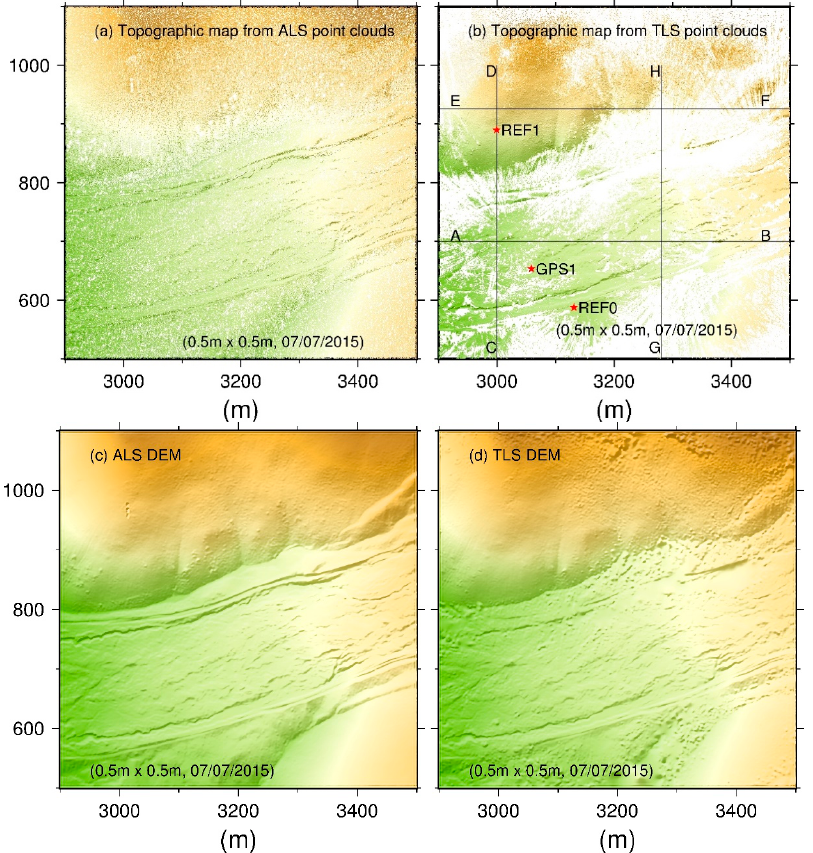
Figure 11. Comparisons of elevation measurements derived from ALS and TLS surveys on 7 July 2015. Both ALS and TLS points have been down-sampled to 0.5-m by 0.5-m grid cells. The location of the scan area is marked in Figure 3b. ( a ) Elevation measurements of the bare-earth ALS points. ( b ) Elevation measurements of the bare-earth TLS points. ( c ) A shaded DEM map derived from the ALS points illustrated in ( a ). ( d ) A shaded DEM map derived from the TLS points illustrated in ( b ). The comparisons of elevation measurements from ALS and TLS points along two profiles (AB and CD) are illustrated in Figure 12. Figure 12c illustrates the differences of the point-elevations along profile AB. The differences indicate the errors of ALS points with regard to TLS measurements and only the cells that have both ALS and TLS points are compared. The mean of the errors is 4 cm with a standard deviation ( σ ) of 34 cm. Root mean square of errors (RMSE) retains a similar value as the standard deviation, approximately one foot (~30 cm). RMSE is computed as: